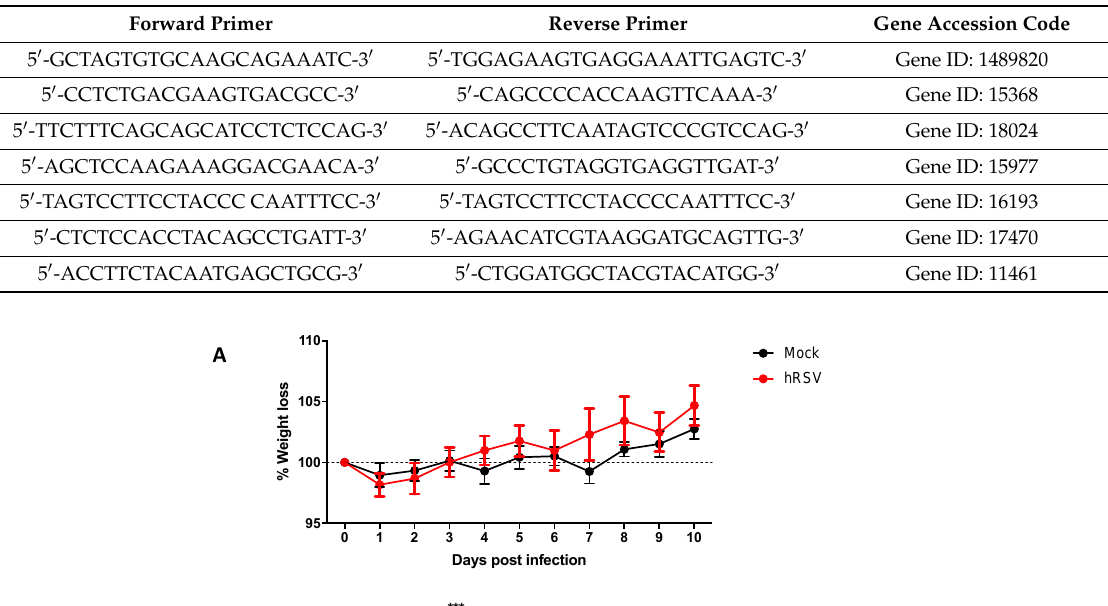
Table 2. List of primers used for real-time quantitative reverse transcription polymerase chain reac- tion (RT-qPCR) analysis.